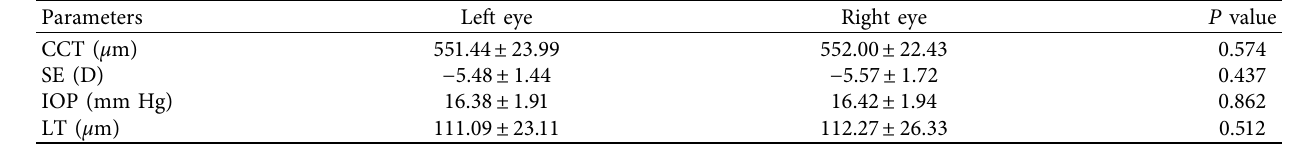
Table 1: Demographics data of the specimens.